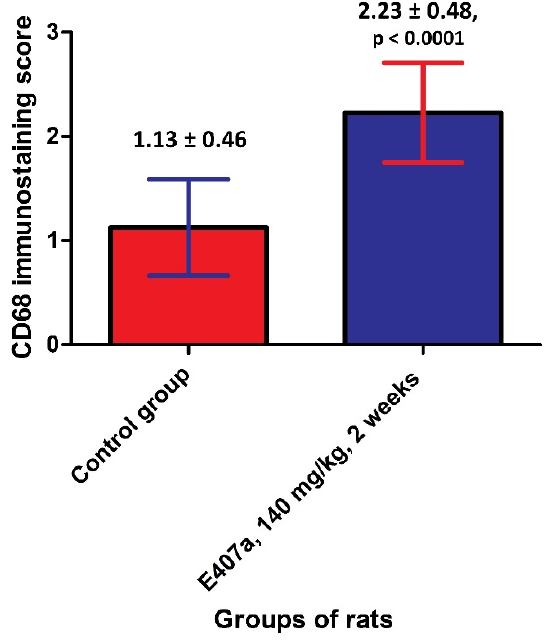
Figure 3. Quantitative analysis of CD68 expression in the small intestine reveals an infiltration of the small intestinal lamina propria with CD68 + cells in rats orally exposed to E407a. Morphological studies were complemented by the determination of inflammation markers in blood serum. Oral exposure to E407a resulted in a 7.4-fold elevation of circu- lating C-reactive protein (CRP) and a 5.3-fold increase in the content of middle molecules (MMs) in blood serum compared with the control group (Table 1).